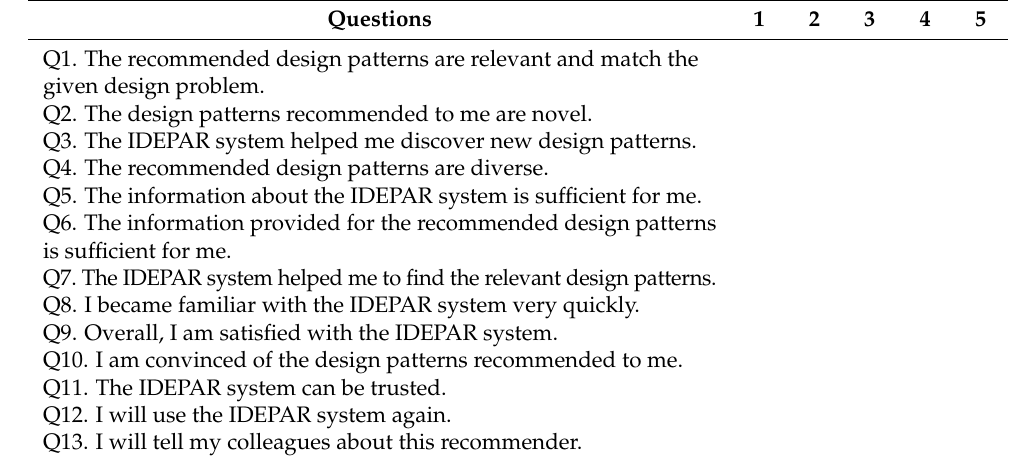
Table A1. Post-test